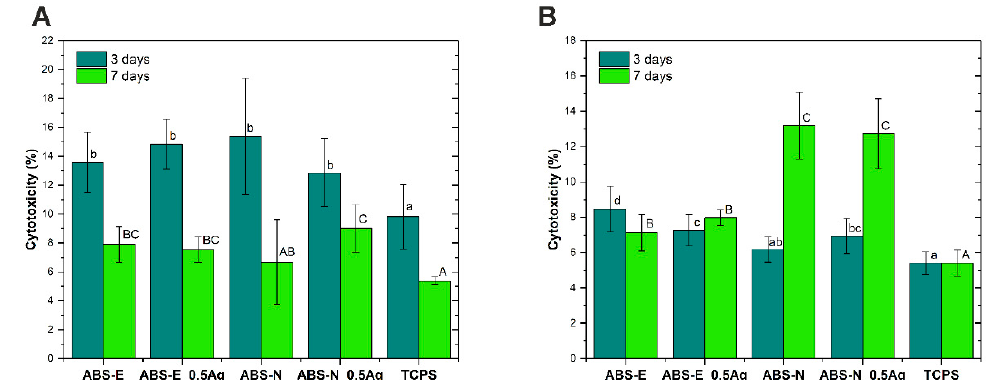
Figure 7. Cytotoxicity of materials evaluated in contact with Saos-2 ( A ) and Hs680.Tr ( B ) cells. The results are presented as mean values ± standard deviation. Statistically significant differences ( p < 0.05) between the tested materials are marked a-d for 3-day culture and A-C for 7-day culture.